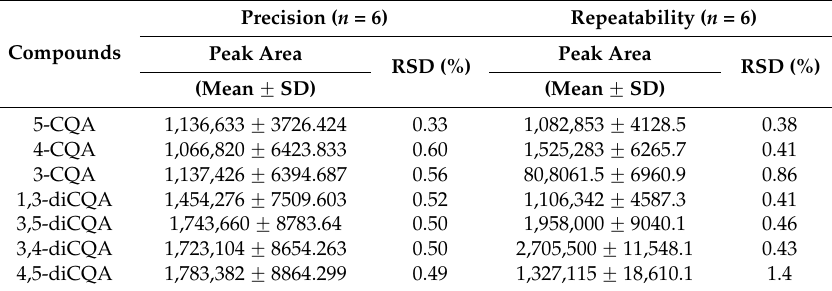
Table 2. Precision and repeatability for the assay of seven